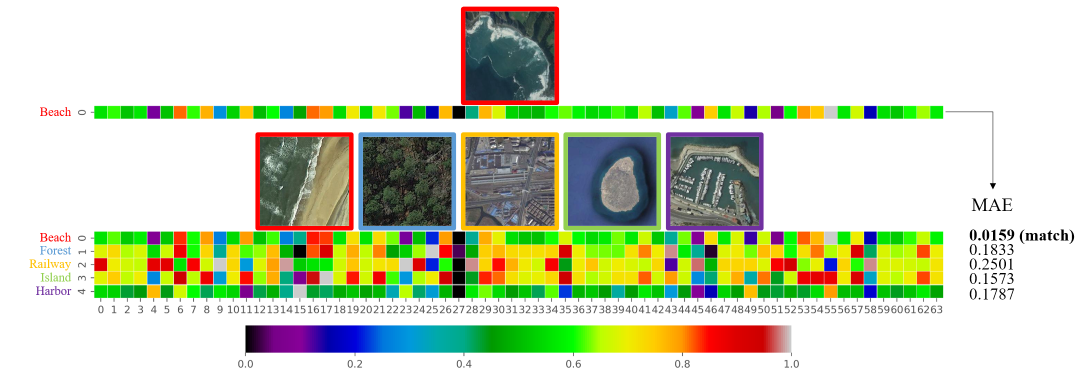
Figure 14. Comparison of channel attention features of a randomly selected query set image and support set images from a training set task on the NWPU-RESISC45 dataset.